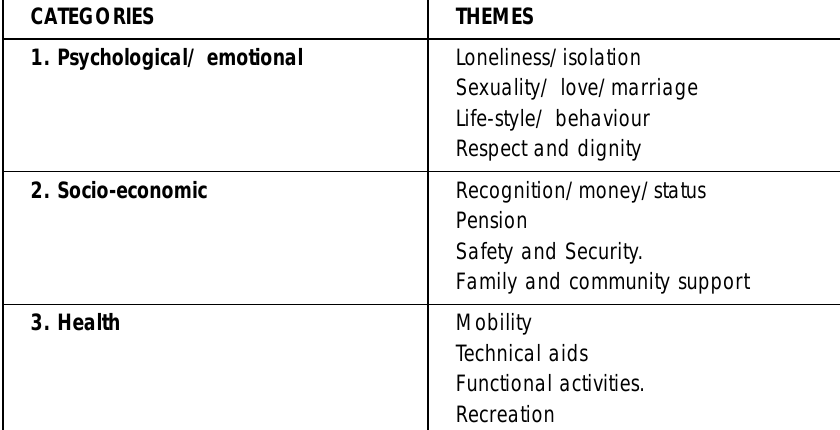
Table 1: Summary of categories and